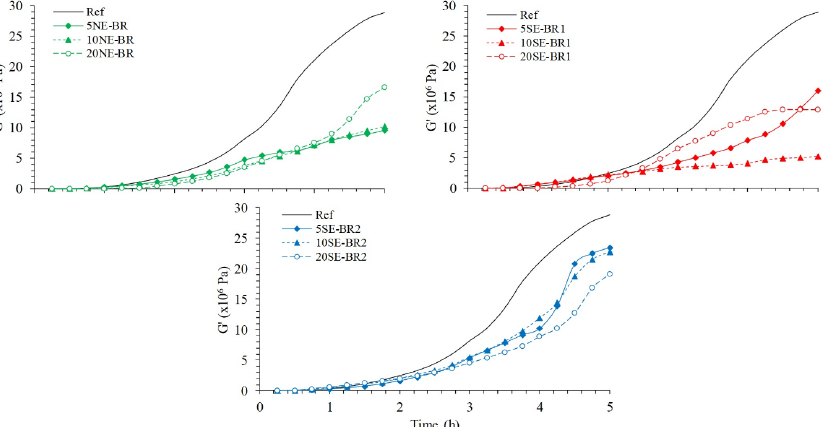
Figure 8 G ain on the consistency of blended pastes. From top to bottom are presented the results for NE-BR, SE-BR1, and SE- BR2,